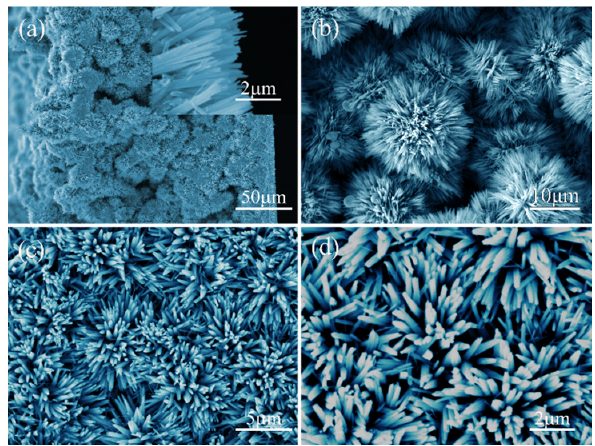
Figure 4. SEM images of TiO 2 nanoarrays grown on horizontally placed ITO substrate: ( a ) Front view of TiO 2 nanoarray; ( b ) A cross-sectional view and an enlarged view of the TiO 2 nanoarray; ( c ) TiO 2 nanoarray bottom view; ( d ) C magnified view.